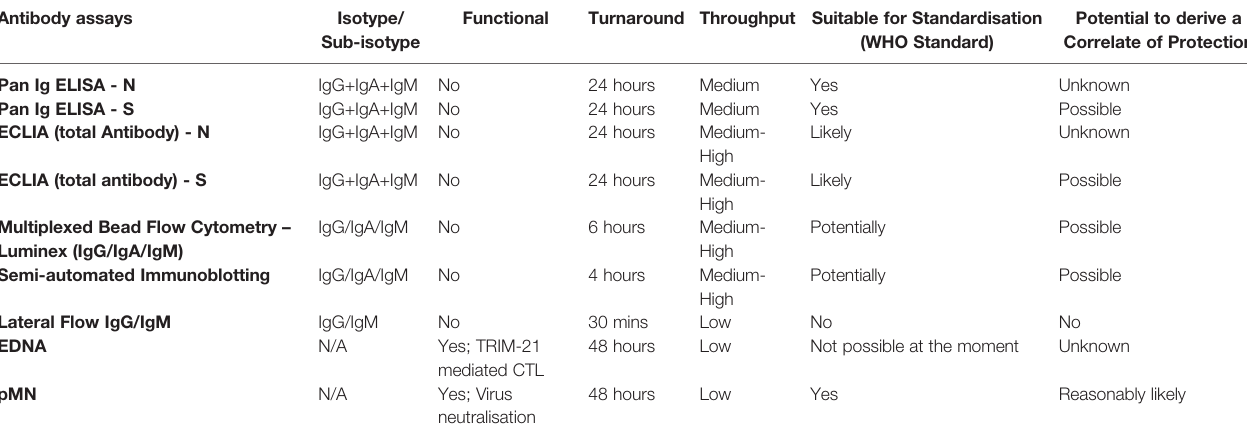
TABLE 3 | Summary of the main features of the antibody-based assays used in this study. Antibody